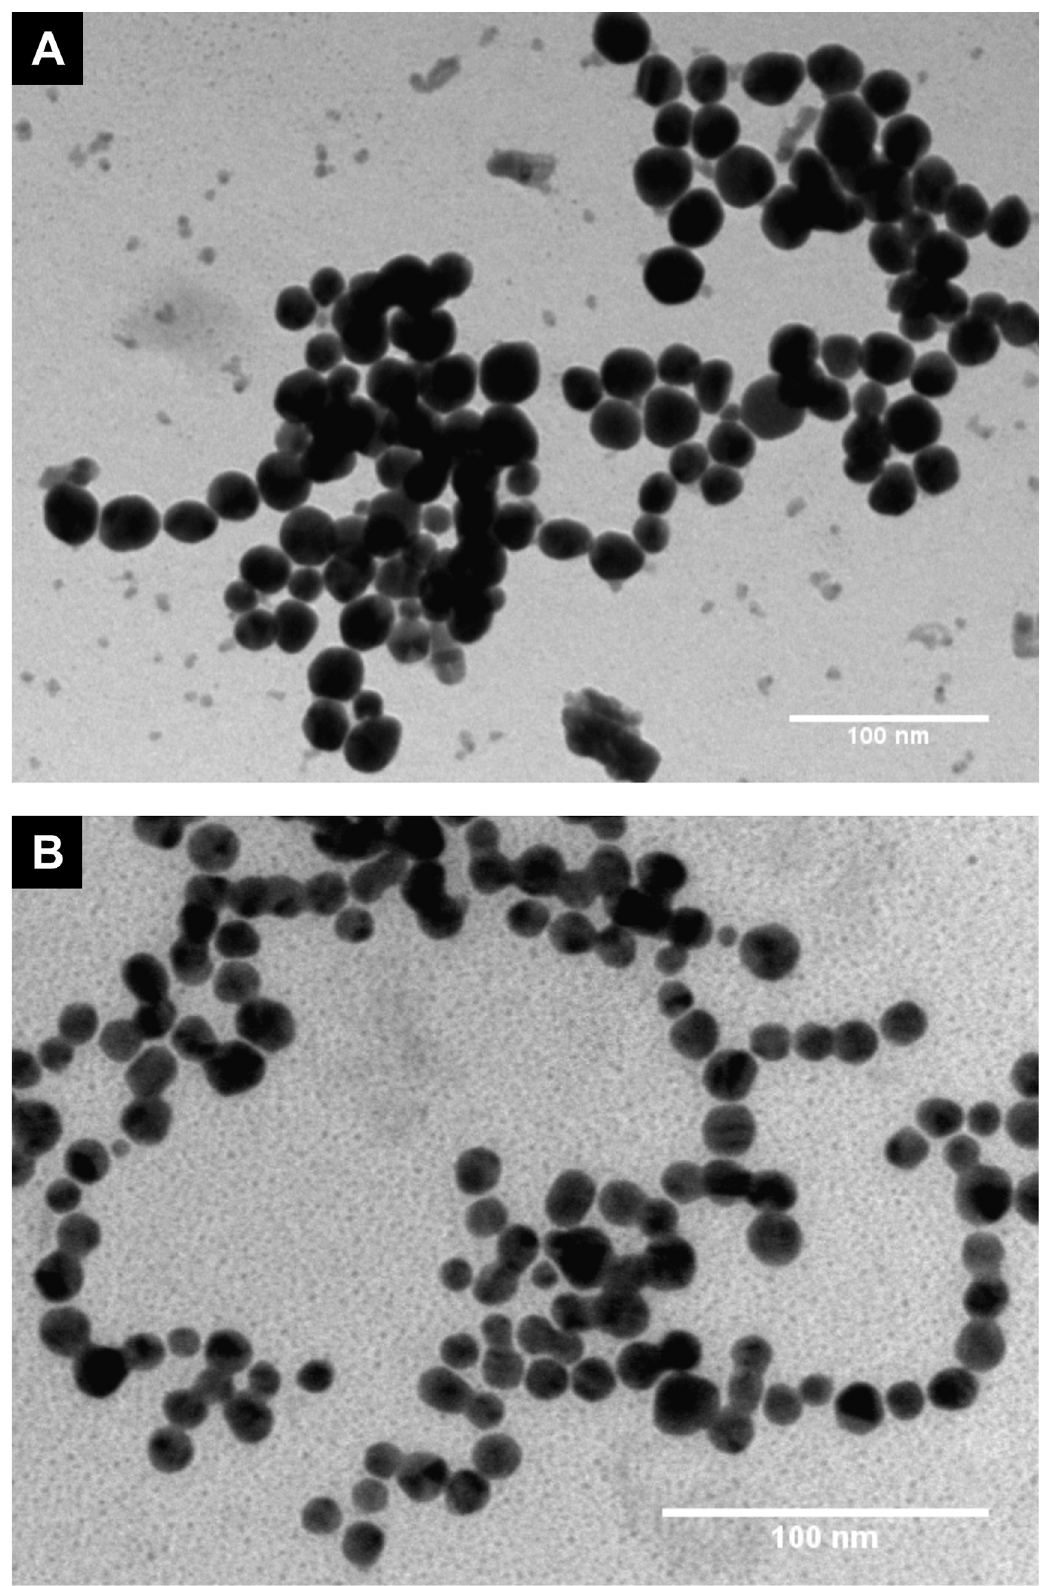
Fig 1. TEM images of (A) PVA-AgNP and (B) PAH-AgNP.